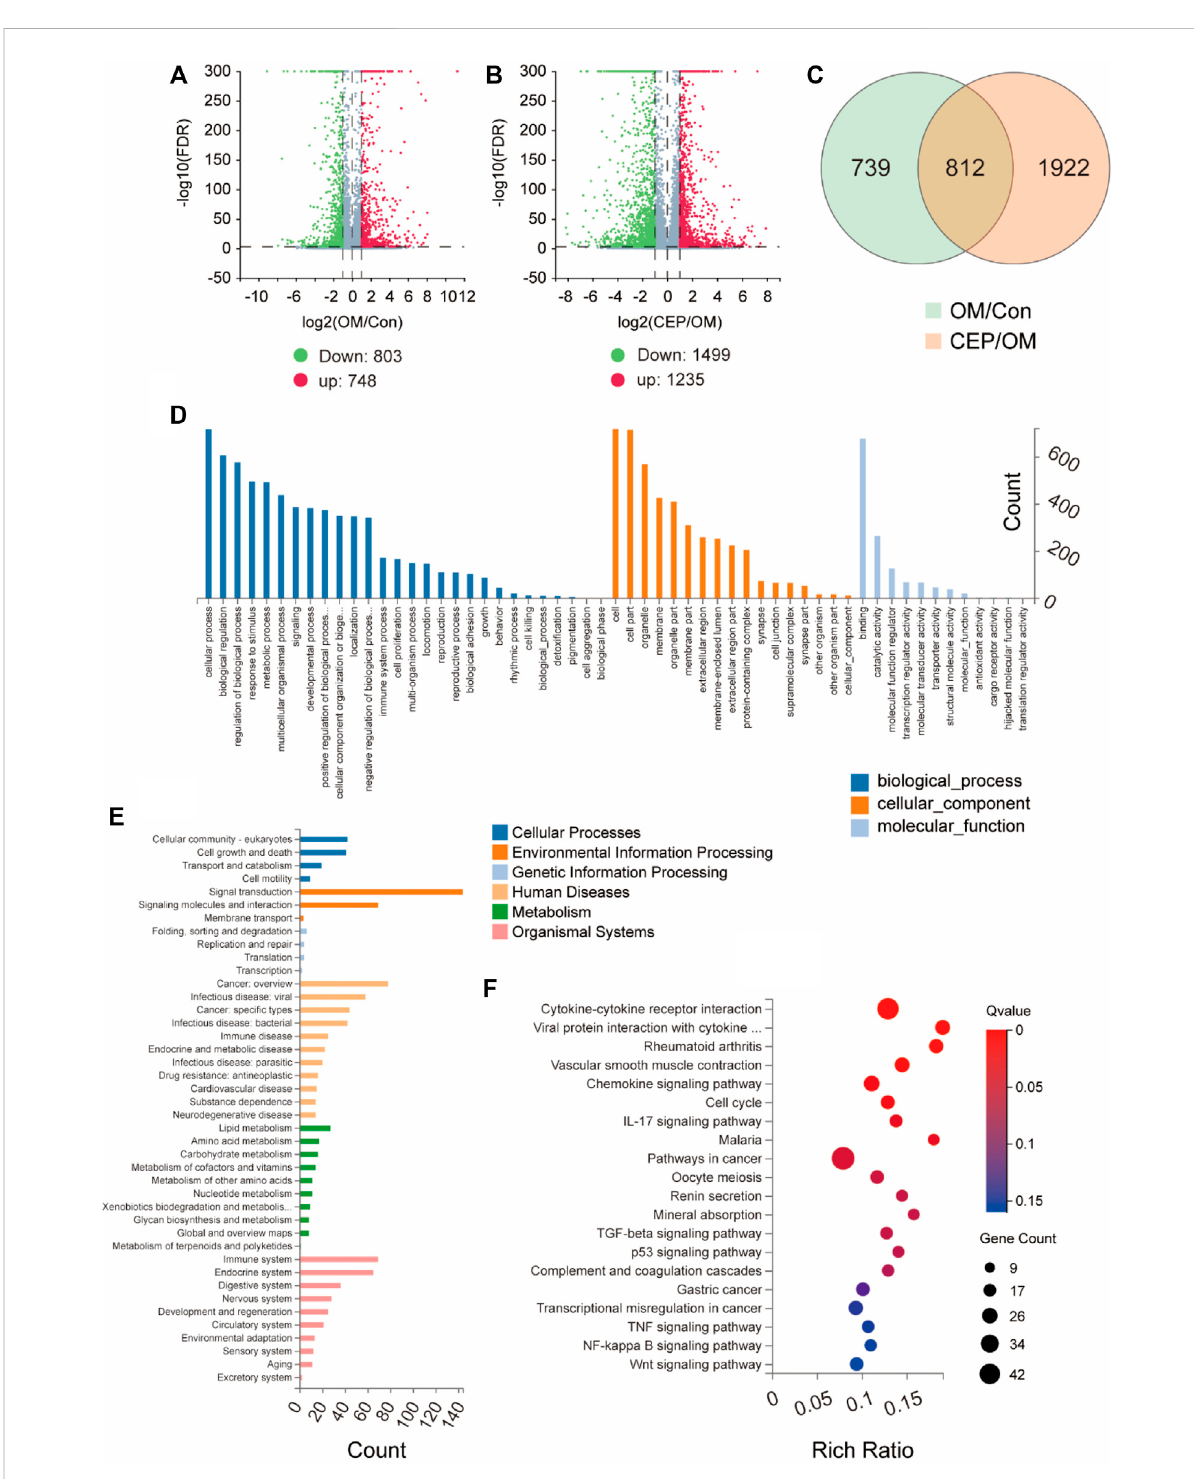
FIGURE 2 GeneexpressionanalysisofVICswithorwithout CEPtreatmentundertheOM. (A) and (B) VolcanoplotsbasedongeneexpressionofVICswith CEP treatments under the OM induction. Log2FC > 1; FDR < 0.001, red plot indicates upregulation, and green plot indicates downregulation; (C) Venn of differentially expressed genes (DEGs) indicate 812 common DEGs involved in the anti-calci fi cation effect of CEP; (D) GO enrichment based on 812 common DEGs; (E) classi fi cation of enrichment; (F) KEGG pathway enrichment based on 812 common